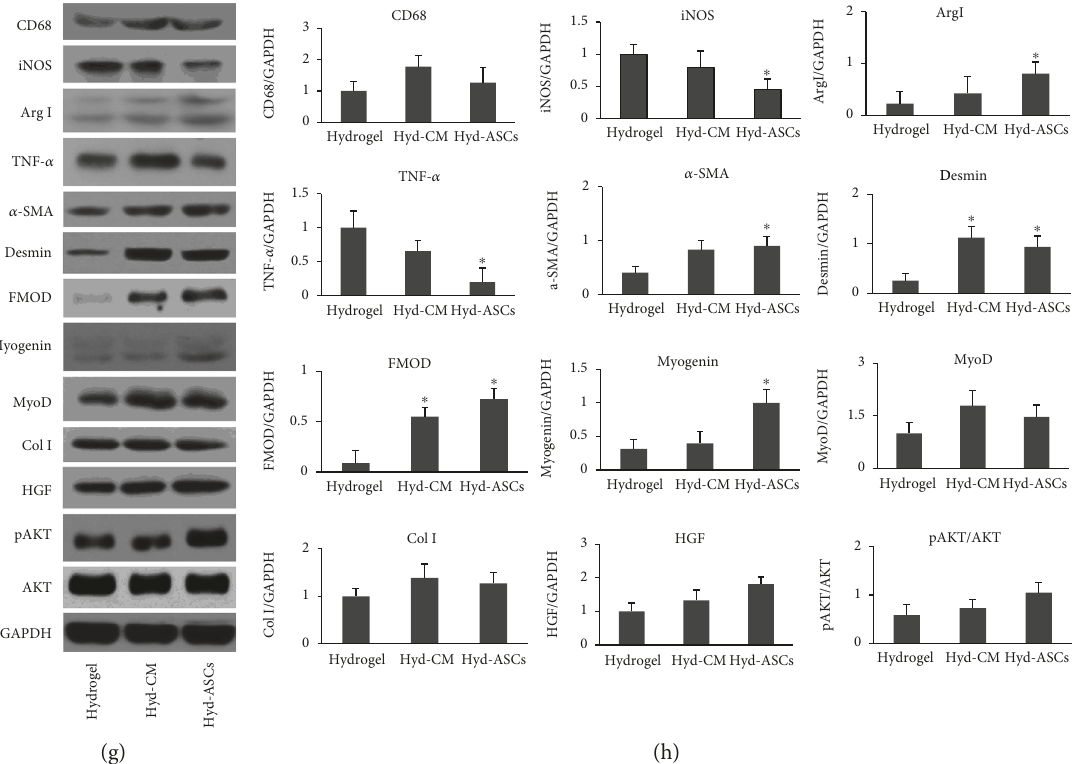
Figure 4: rASC-based hydrogel regulating in fl ammation, myogenesis, and vasculogenesis during muscle regeneration. (a) and (b) displayed the in fl ammation, angiogenic, and myogenic mRNA expression at 5 d and 2 w during muscle repair and regeneration. mRNA expressions were normalized to 18S for rat muscles. (c), (d) IF staining of Arg I (red) and CD68 (green) at 5 d and 7 d in wound areas. (e) Arg I +/CD68+ ratio manifested more prohealing M2 pro fi le in the Hyd-ASC and Hyd-CM groups than in the hydrogel group. Scale bar =20 μ m. (f) The IF staining of α -SMA and CM-Dil-labeled ASCs at 2 w post injury. Scale bar =100 μ m. Nuclei in blue, ECs in green, and rASCs in red. (g) The pan macrophage marker CD68, M1 marker iNOS, M2 marker Arg I, endothelial cell marker α -SMA, myogenic markers Myogenin and MyoD, other prohealing-related protein like desmin and fi bromodulin (FMOD), HGF, collagen I, in fl ammation protein TNF- α , signaling pathway protein AKT, and pAKT expressions were detected by Western blot. GAPDH was loaded as control. (h) Relative protein expression was analyzed by fold of GAPDH or ratio of phosphorylation to total protein. Data were mean ± SEM of three independent experiments. ∗ p < 0 05 versus hydrogel